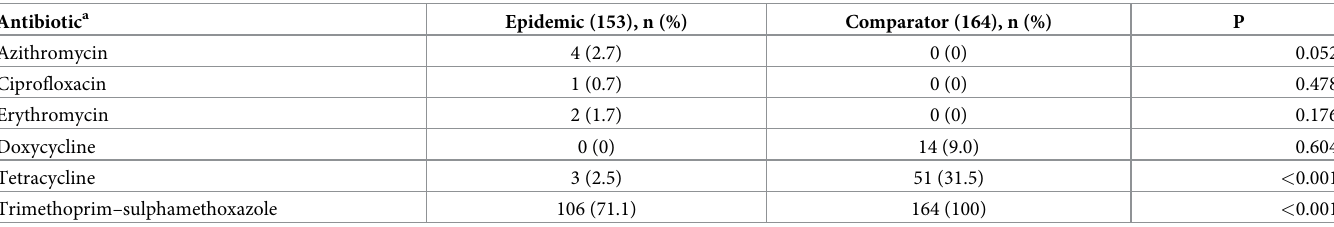
Table 4. Antimicrobial resistance pattern of Vibrio cholerae isolated from the cases (during the epidemic) and the controls (during the comparison period). Antibiotic a Epidemic (153), n (%) Comparator (164), n (%) P Azithromycin 4 (2.7) 0 (0) 0.052 Ciprofloxacin 1 (0.7) 0 (0) 0.478 Erythromycin 2 (1.7) 0 (0) 0.176 Doxycycline 0 (0) 14 (9.0) 0.604 Tetracycline 3 (2.5) 51 (31.5) < 0.001 106 (71.1) 164 (100) < 0.001